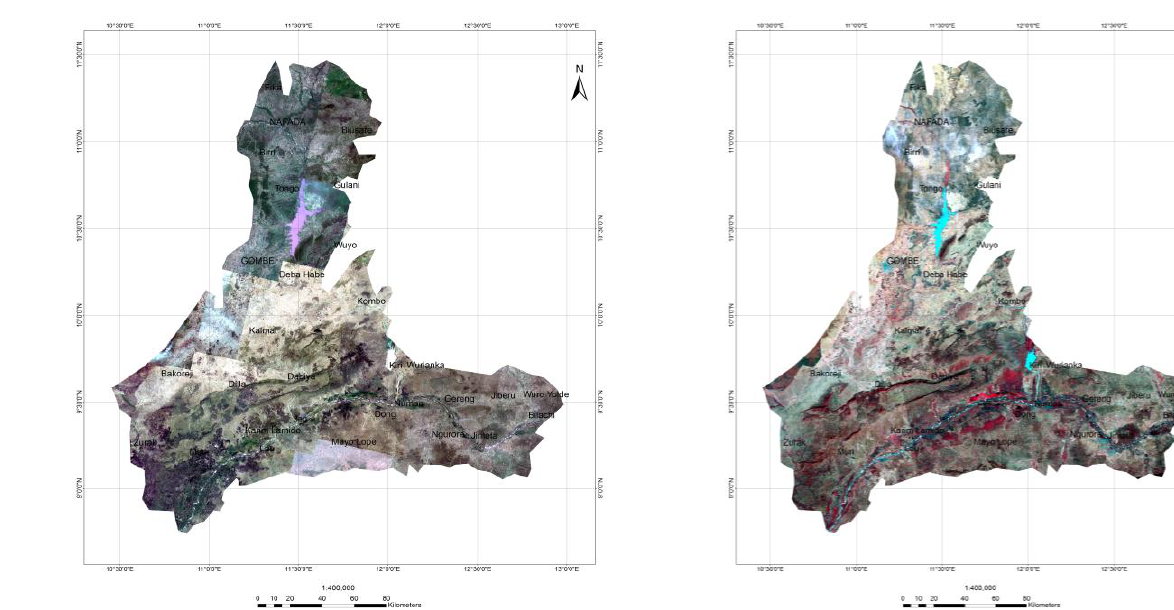
Figure 2. Geological map of the Upper Benue Trough (modified from NGSA MAP, 2004)